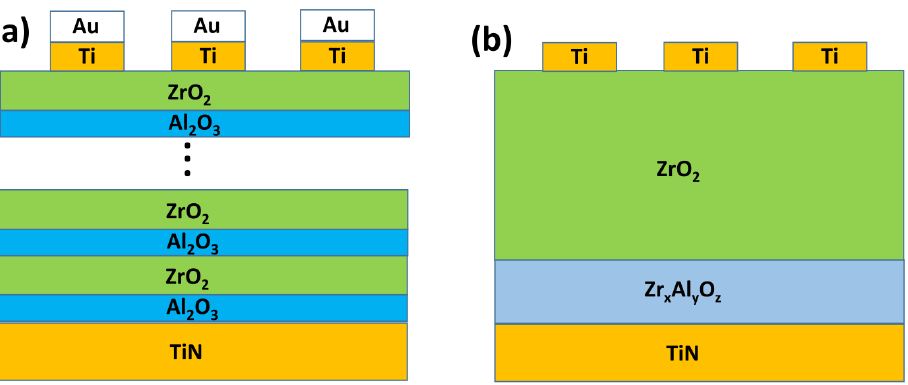
Figure 1. Schematic representation of ( a ) periodical ZrO 2 :Al 2 O 3 structures and ( b ) ZrO 2 films grown on buffer Zr x Al y O z layers on bottom TiN electrodes. The component-material layer thicknesses are not to scale.